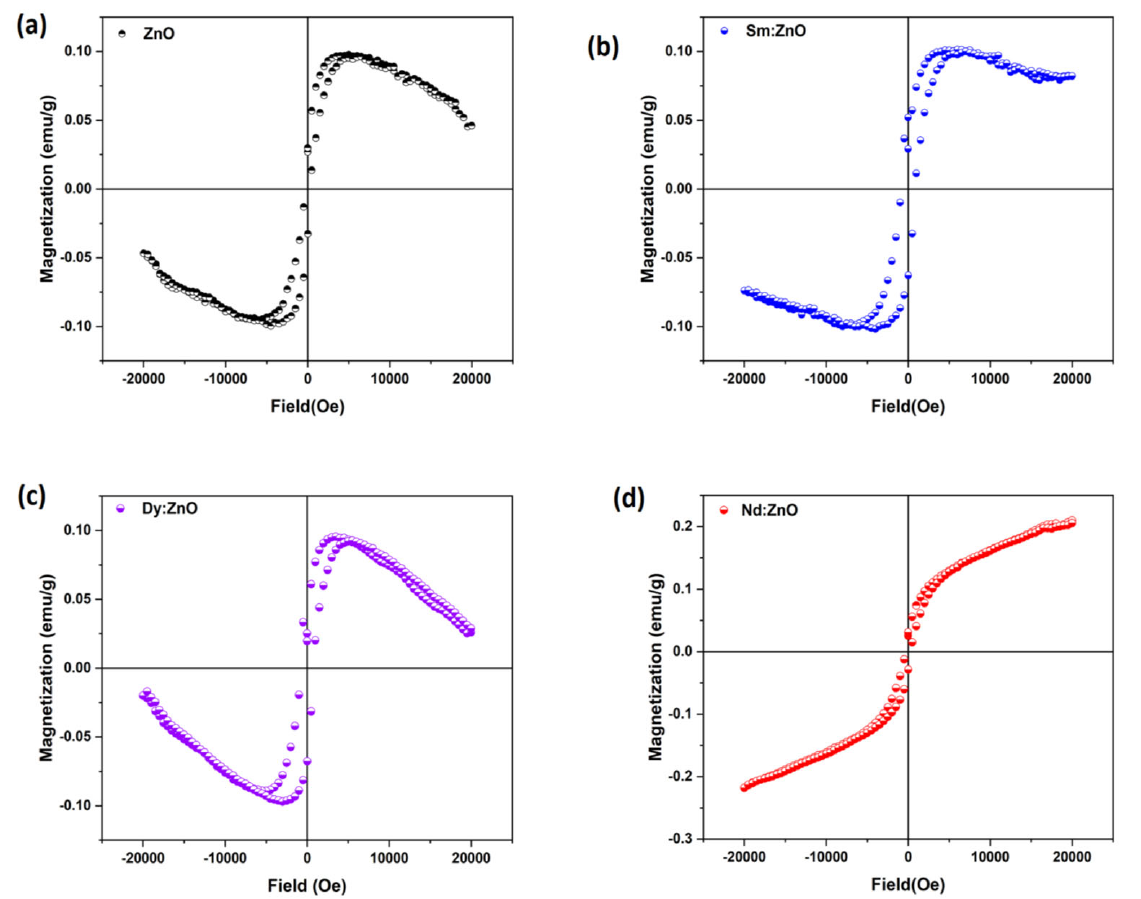
Figure 10. Room temperature magnetization vs. magnetic field (M-H loops for ( a ) ZnO ( b ) Sm:ZnO ( c ) Dy:ZnO ( d ) Nd:ZnO.